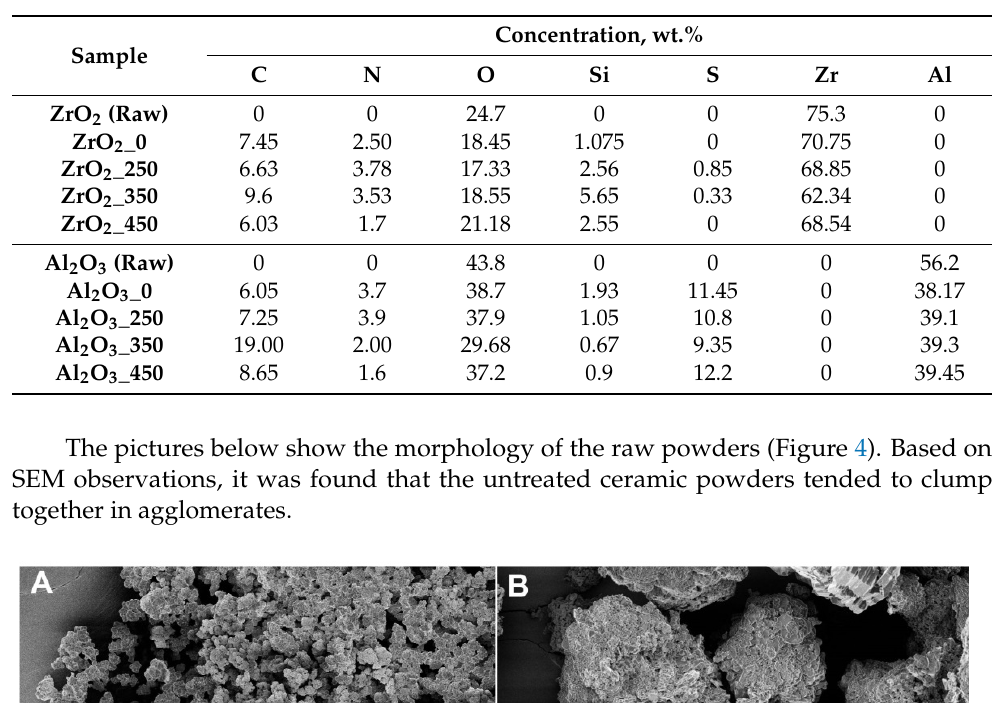
Table 2. Results of the chemical composition for all samples analysis with an EDS probe.